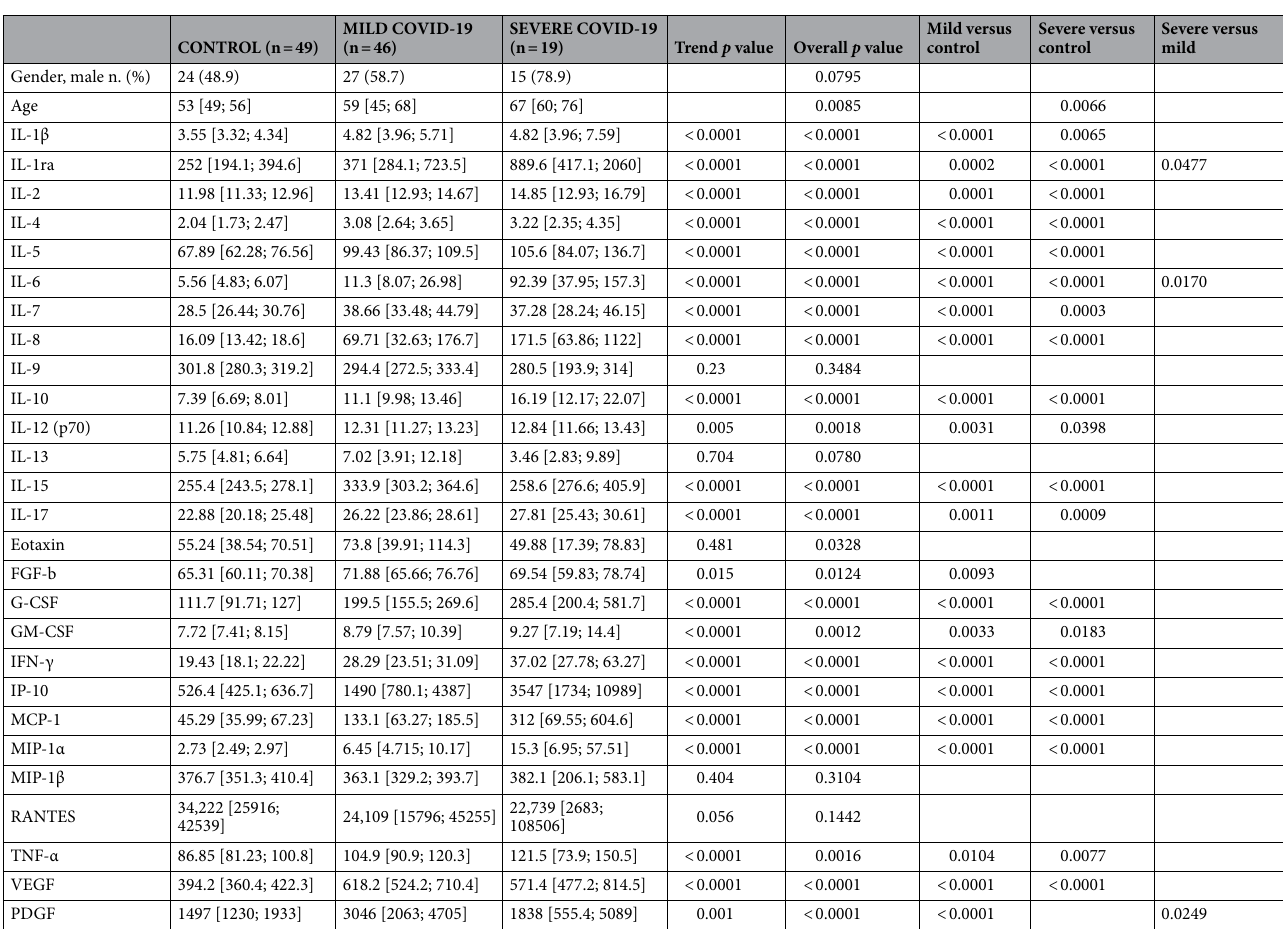
Table 1. Serum concentration (pg/ml) of cytokines, chemokines and growth factors (Wave 1). Results are expressed as median and range [25% percentile; 75% percentile] or number of cases (%). Jonckheere–Terpstra test was used to assess the trend between groups. The non parametric Kruskall Wallis test was applied to assess the difference among three groups followed by Mann Whitney U test for pairwise